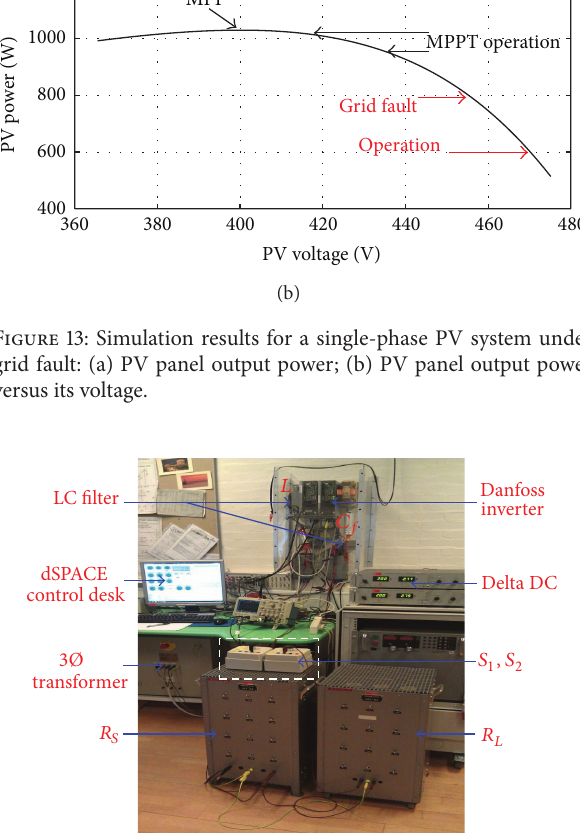
Figure 14: Experimental setup of a single-phase grid-connected